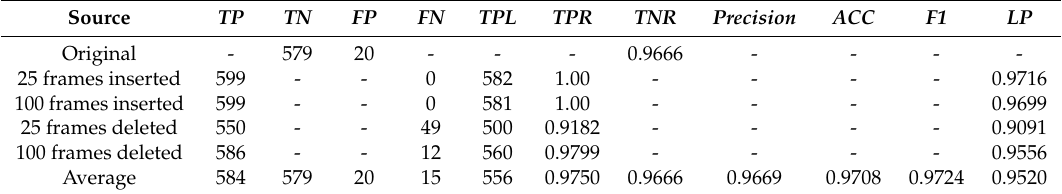
Table 2. Test results of the first dataset.